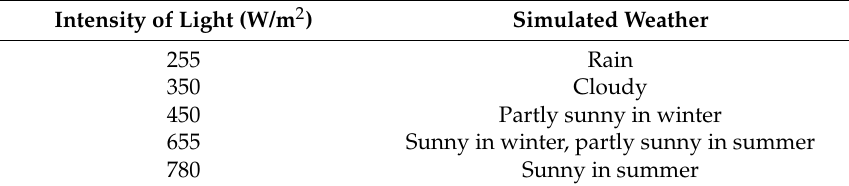
Table 1. Simulated weather as a function of solar intensity.